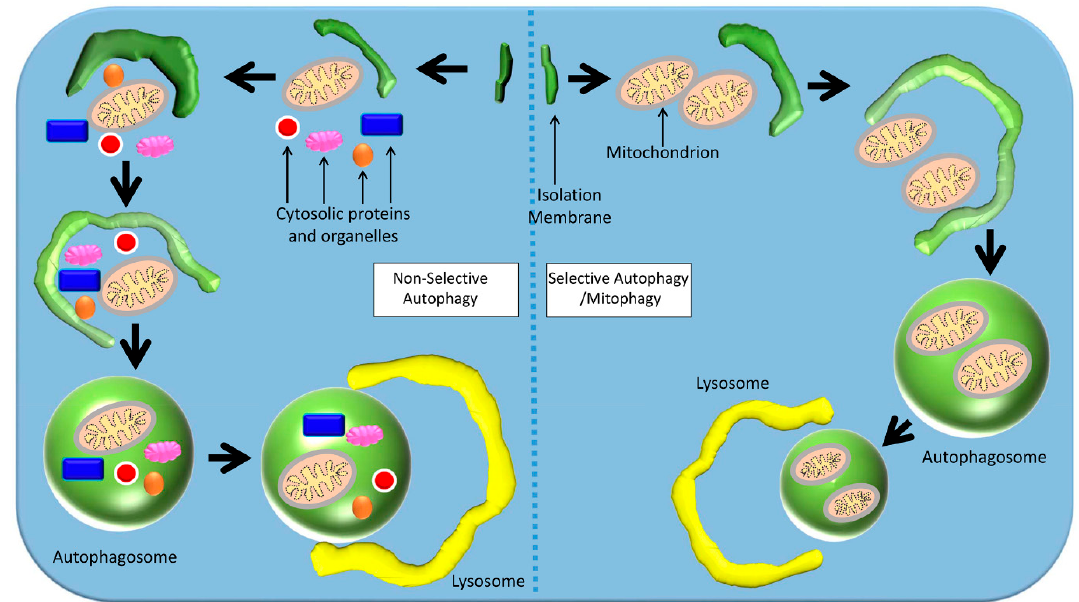
Figure 3. Mechanisms of selective and non-selective autophagy. In non-selective autophagy, a double- membraned autophagosome non-selectively engulfs components of the cytoplasm around its target. In selective autophagy, the autophagosome targets a specific organelle (e.g.,